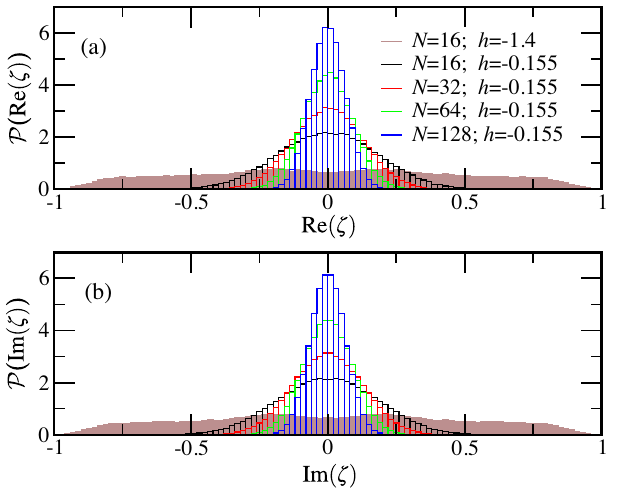
FIG. 6. Distribution of the (a) real and the (b) imaginary part of the correlation function ζ ð t Þ . The “ empty ” histograms correspond to initial preparations with averaged energy density, which is h ¼ − 0 . 155 (high-energy regime). The brown “ filled ” histogram corresponds to a network with N ¼ 16 and initial preparations with averaged energy density, which is h ¼ − 1 . 4 (low-energy regime; the smallest eigenvalue of the linear system was approximately − 1 . 7 ). The number of modes are indicated by the color of the histogram in the inset. The average optical power was kept constant a ¼ 1 while χ ¼ 0 . 01 . In all these simulations the integration time was as long as t ¼ 10 5 and we have generated more than 32 × 10 4 correlations ζ for the statistical processing.